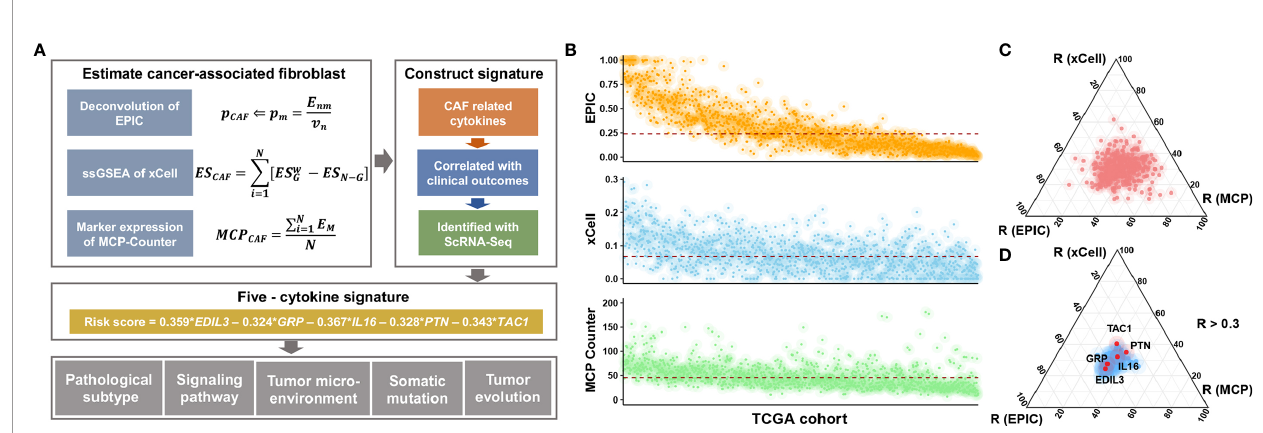
FIGURE 1 | Study fl ow chart and the selection of candidate cytokines. (A) Where E nm is a matrix (n × m) of the n gene expression pro fi les from the m cell types; V n is the vector of all n genes expressed from the bulk sample to deconvolve; and p is a vector of the proportions from the m cell types in the given sample. ES w G is the weighted enrichment score (ES) of a given signature G , and ES N-G is the ES of the remaining genes from the data set of N genes. E M is the gene expression of canonical CAF markers in BC datasets. (B) Inferred CAF proportion scores of TCGA BC cases by three algorithms (see Methods ). EPIC, xCell, and MCP-Counter indicated the assumed CAF proportion, the enrichment score of CAF-related gene signature, and the relative expression level of CAF marker genes, respectively. And the red dotted line indicated median values. (C) The results of correlation analyses between all 695 cytokines and CAF proportion scores derived from algorithms. (D) The 106 CAF-related cytokines indicated medium and high correlation with CAF proportion scores (R > 0.3), and a total of fi ve cytokines showed prognostic